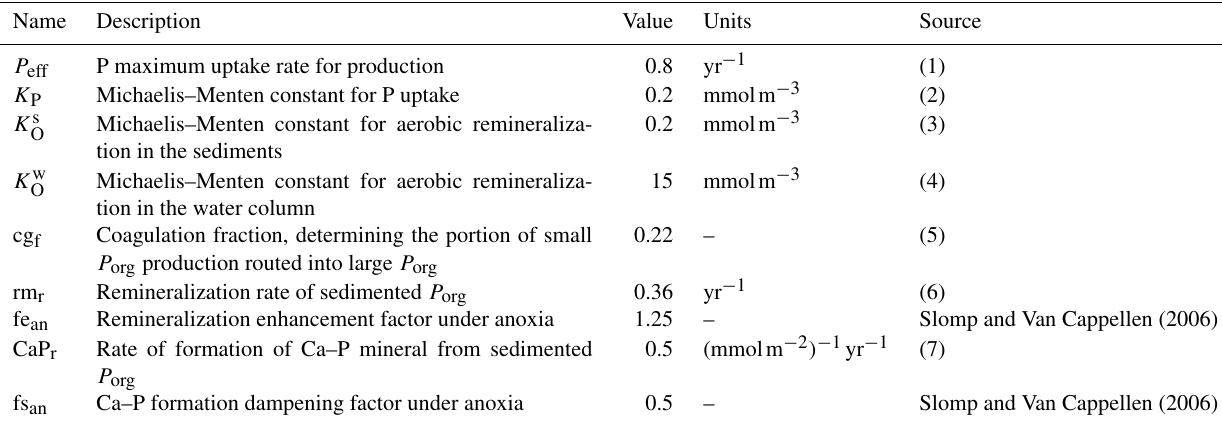
Table 4. Parameters set pertaining to the P org cycle of the model and coupled biogeochemical